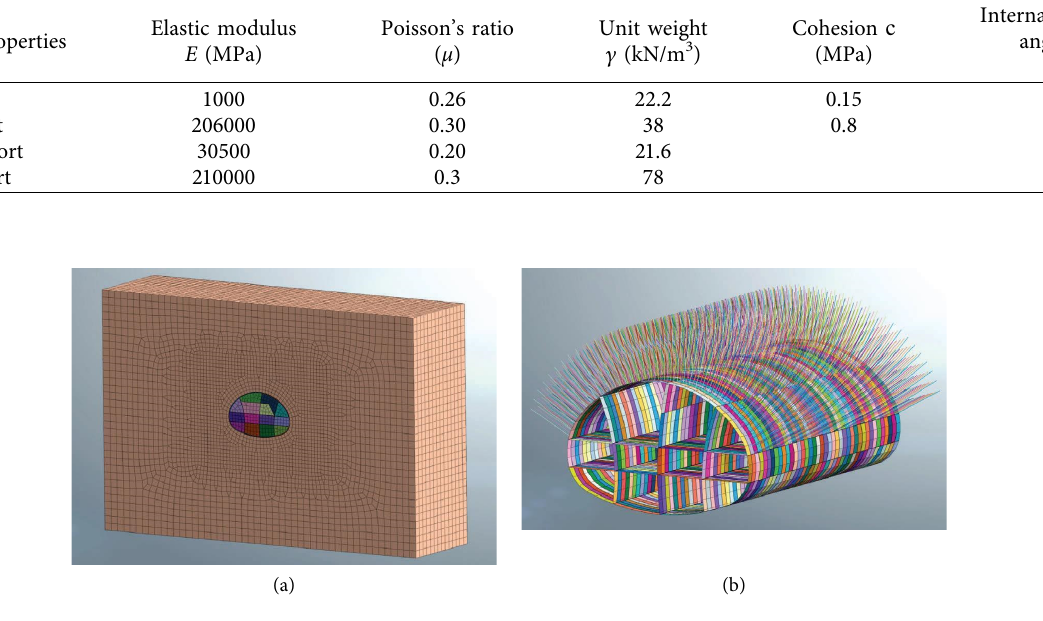
Figure 2: Numerical calculation models: (a) overall model and (b) preliminary bracing and anchor bolt model.